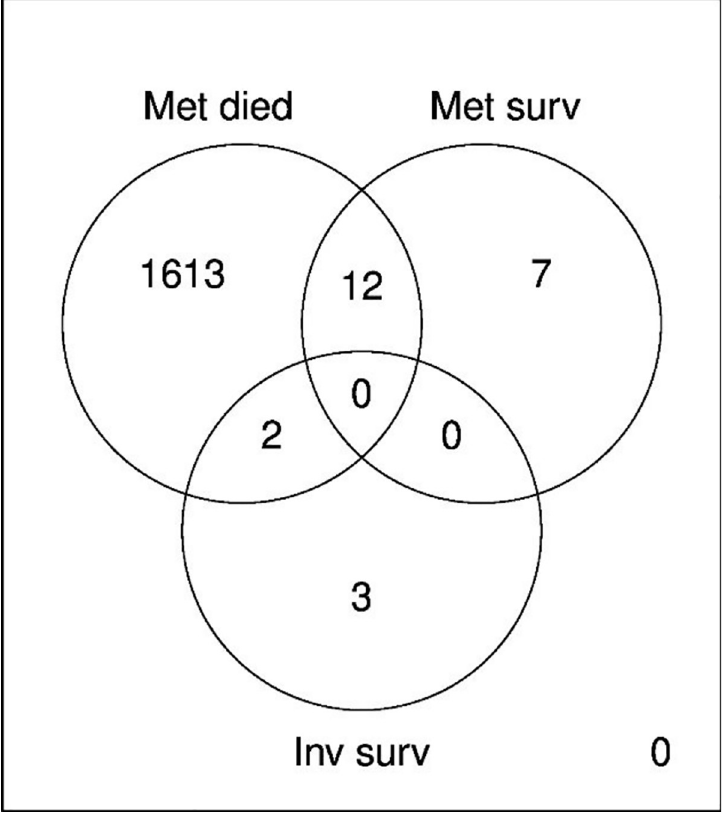
Fig 6. Venn diagram for the three strata with significantly different gene expression profiles; metastatic cases who died (labeled as met died), metastatic cases who survived (met surv), and invasive cases who survived (inv surv).